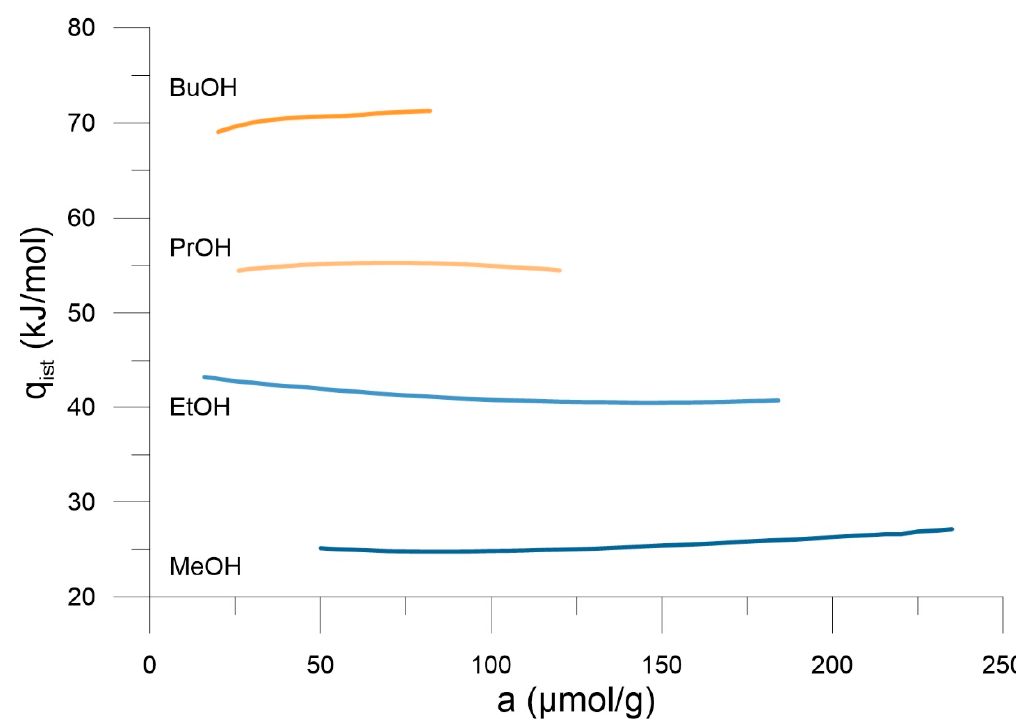
Figure 3. The plots of isosteric enthalpy of n-alcohols adsorption on SWCNH in the range of 373–433 K. To determine the values of adsorption enthalpy at zero coverage we applied the same procedure as proposed previously [27].